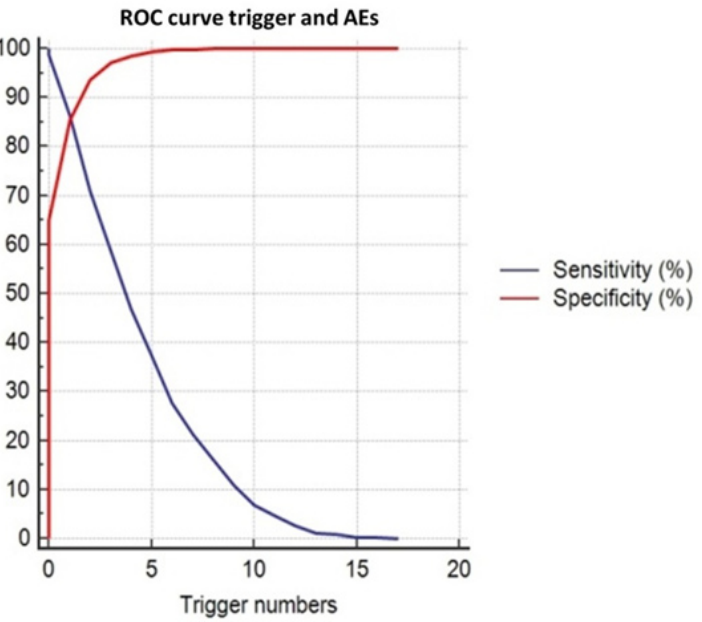
Figure 1. ROC analysis of two random triggers. ROC curve shows that the presence of two triggers in clinical records indicates an adverse event with a high probability.